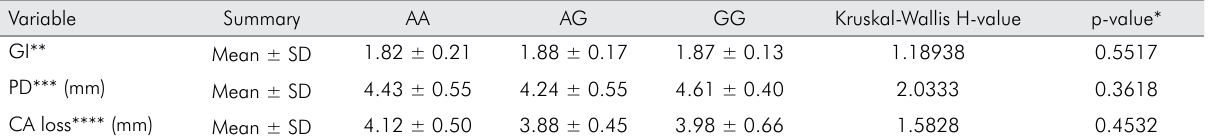
Table 1. Comparison of genotypes in respect to different variables for localized aggressive periodontitis patients by Kruskal-Wallis one way ANOVA.